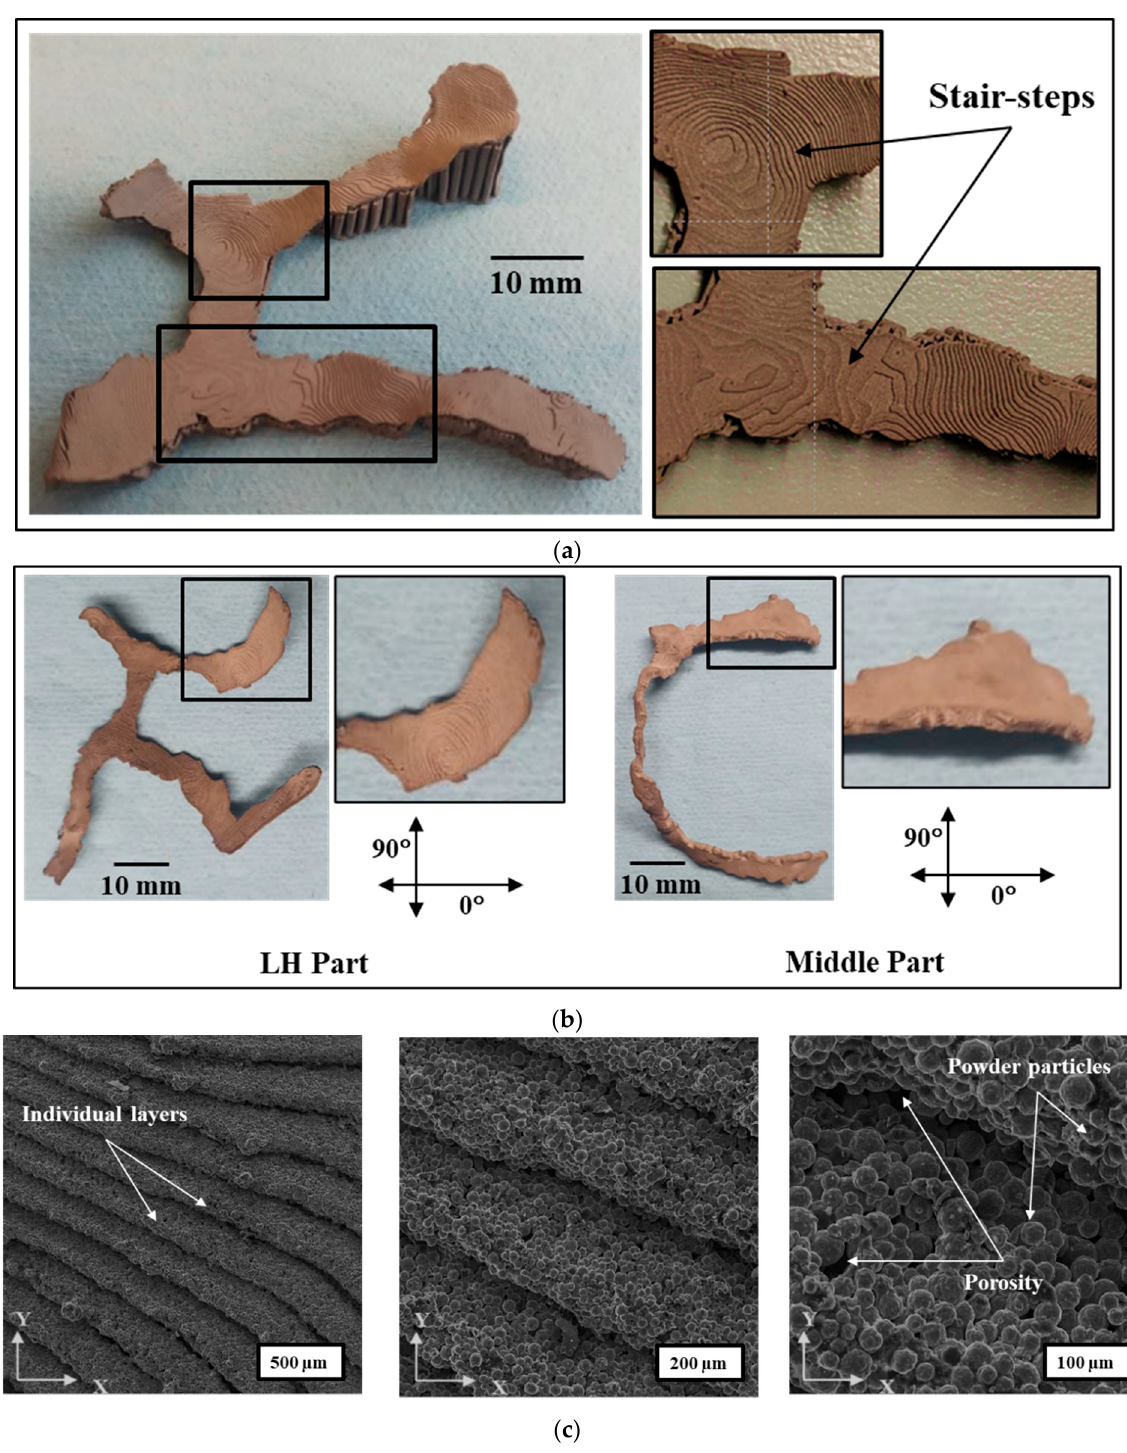
Figure 9. ( a ) Stair-step effects from layer-by-layer printing due to Z-gradient of the implant surface; ( b ) surface roughness of LH and Middle unpolished sintered parts measured in terms of ‘R a ’ along the 0 ◦ and 90 ◦ of the print direction; ( c ) SEM (unetched unpolished